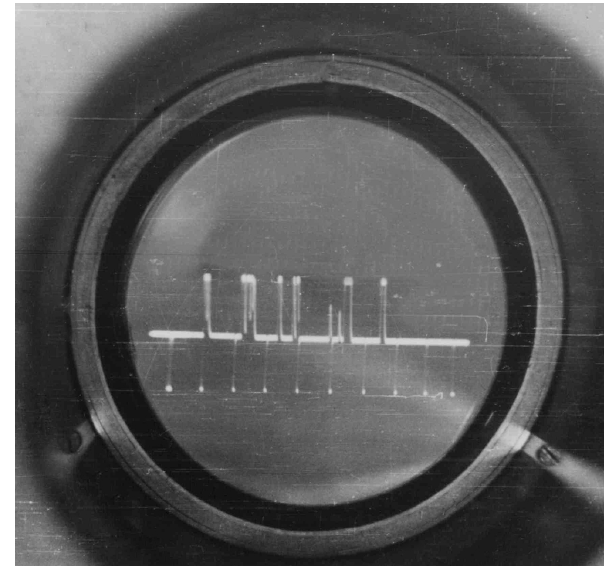
Figure 11. A-Scope with echo signals.